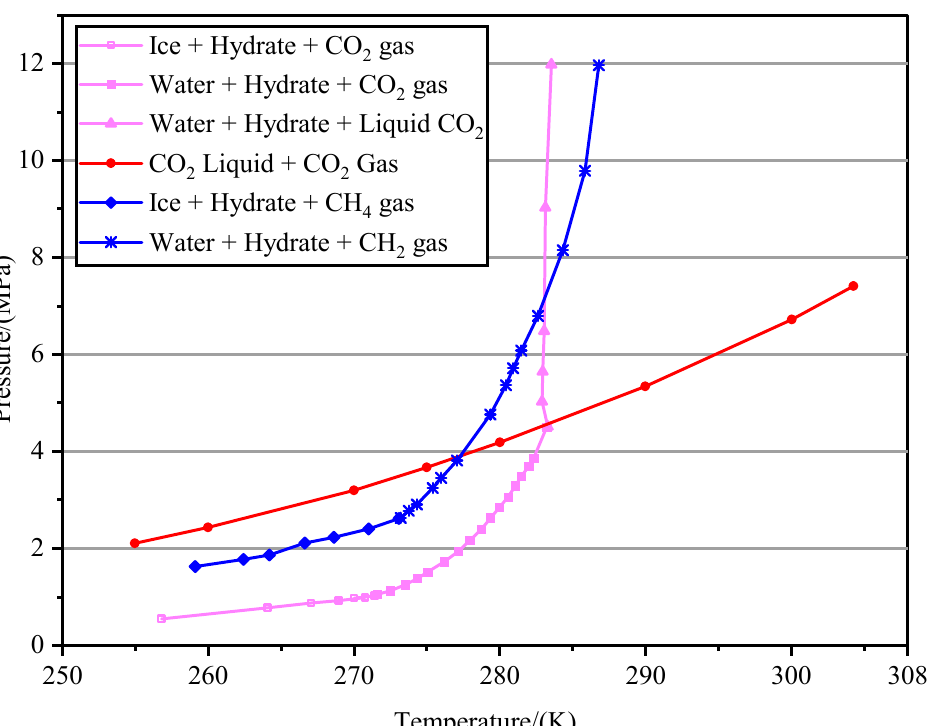
2 and CH 4 hydrate in this